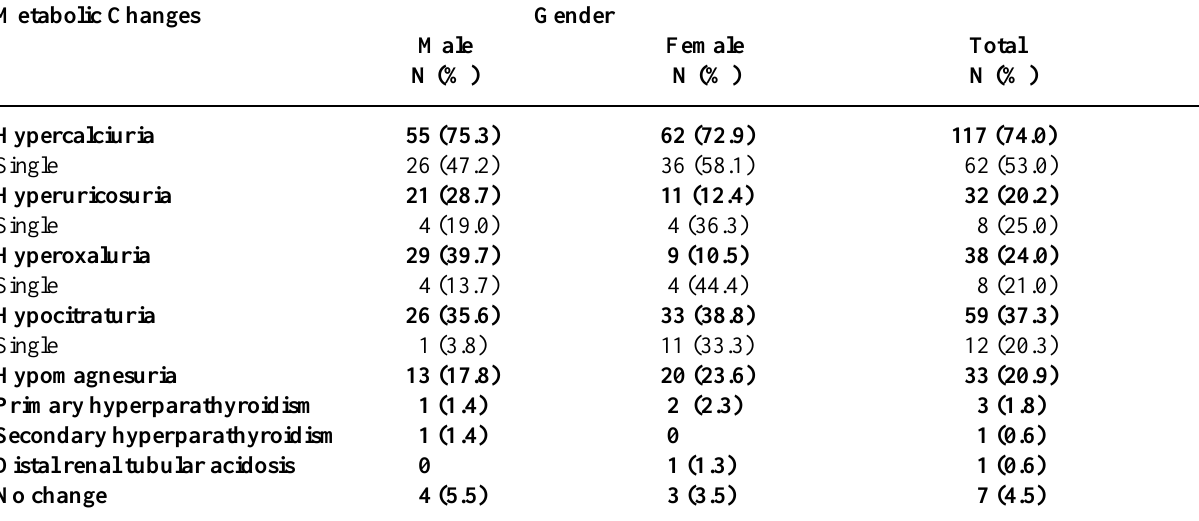
Table 1 – Absolute and relative frequency of metabolic changes diagnosed in the 158 patients under study (73 males and 85